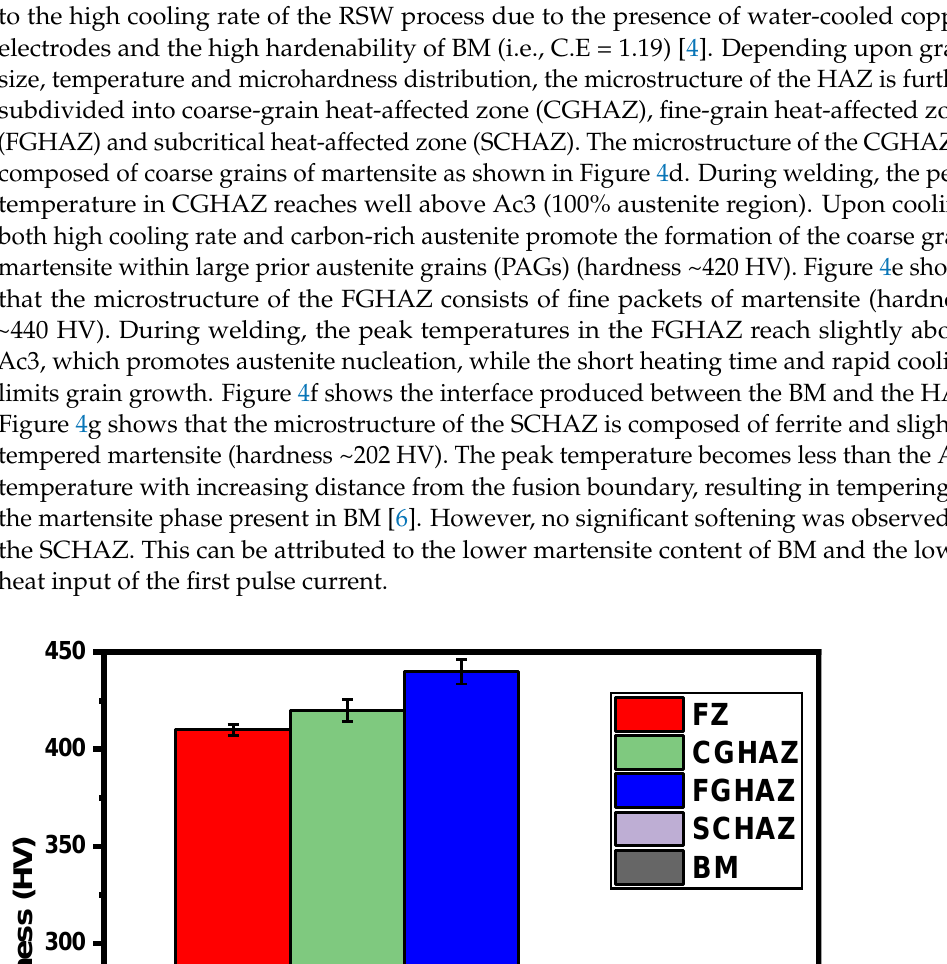
√ t rule does not